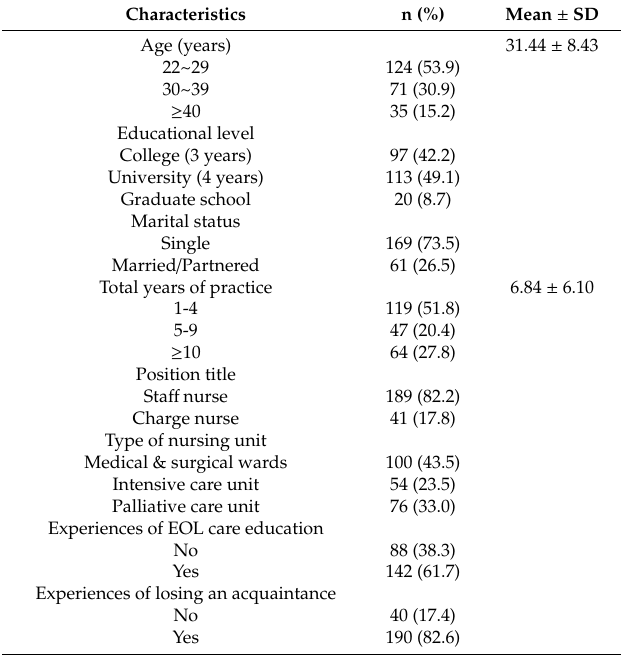
Table 1. Socio-demographic and Clinical Characteristics of Hospital Nurses (N =